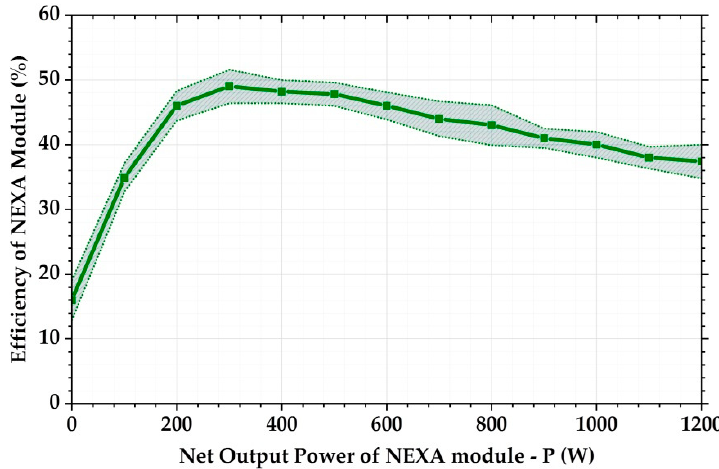
case, in which the decrease is more dramatic, this is due to a larger ratio of the NEXA module’s self-consumption to the amount of H 2 consumed. At maximum load (i.e., at rated power of 1200 W), the NEXA module has an efficiency of approx. 38%.